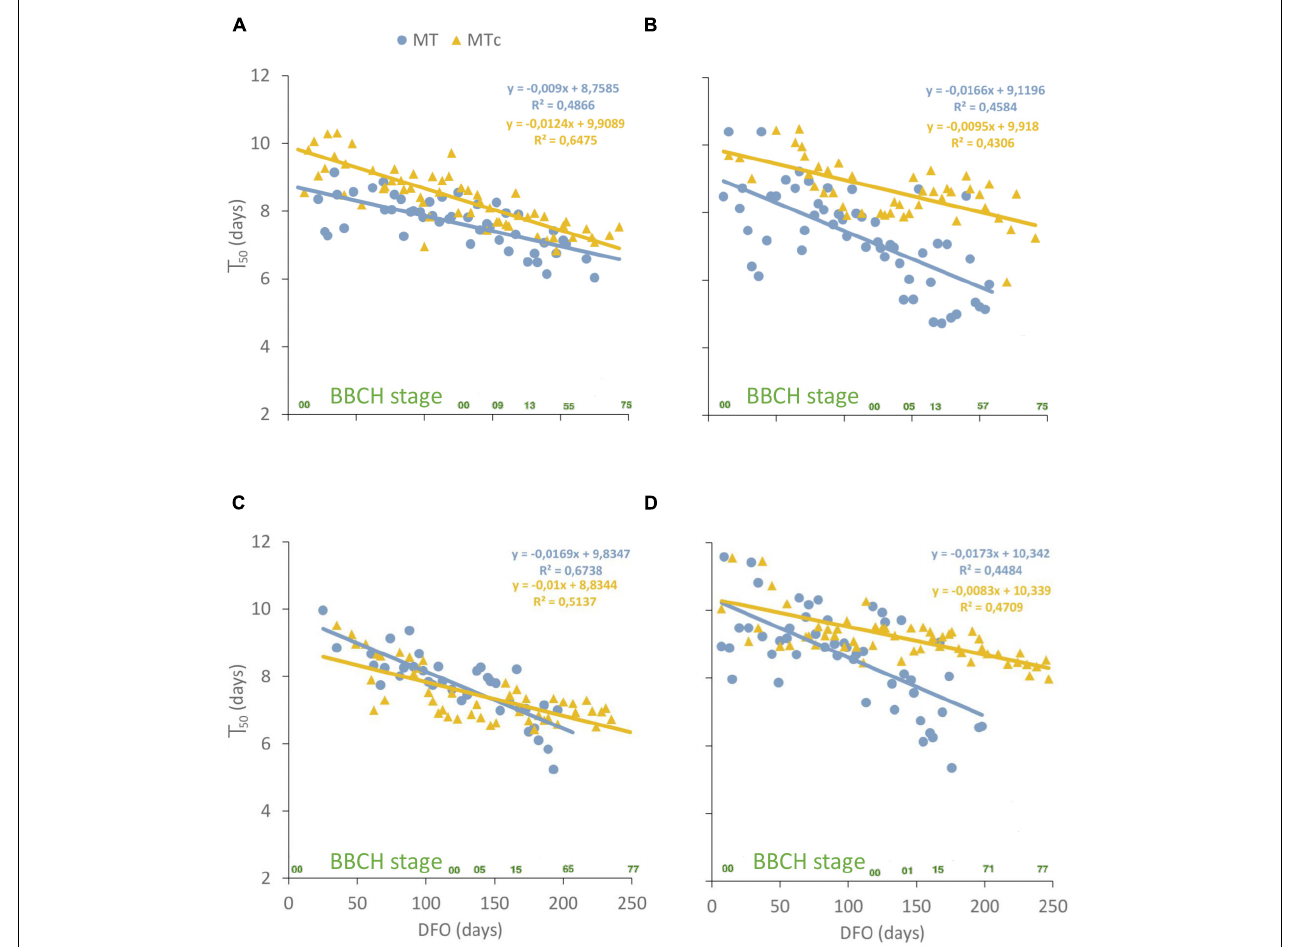
FIGURE 5 | Scatterplot showing the T 50 values, measured in days, at different days from the start of overwintering (DFO) for MT (blue dots) and MTc (yellow triangles) samples during year 1 (A) , 2 (B) , 3 (C) , and 4 (D) . Linear regression parameters and R 2 are highlighted in blue for MT and yellow for MTc samples. The phenological stages of grapevine (BBCH scale) are reported in green on the x